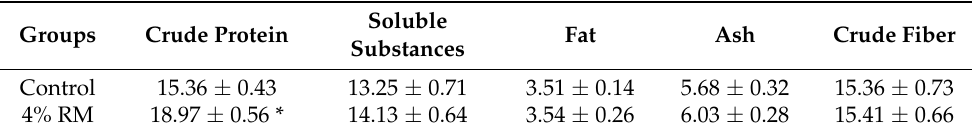
Table 2. Proximate composition of the P. ostreatus mycelium grown on potato dextrose agar (%, dry weight basis). * indicates a significant difference at p < 0.05 compared with the control